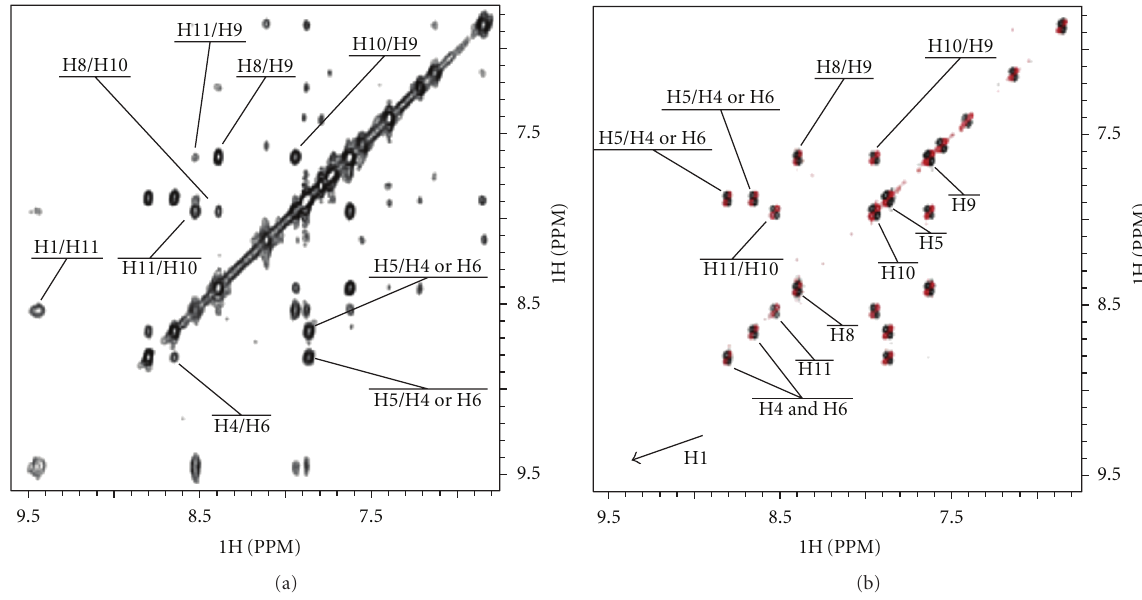
Figure 2: Expanded contour plot of a 300ms mixing time NOESY spectrum (600 MHz) of the 14-mer dG( N 2 )-3ABA duplex dissolved in 100% D 2 O phosphate bu ff er, pH 6.9 (left), depicting NOE interactions among the aromatic protons of the duplex. NOE peaks are particularly strong among the aromatic 3ABA protons facilitating their assignment. Especially relevant is the 3ABA(H1-H11) cross-peak which allows identification of the di ff erent aromatic rings. Identical region of a DQF-COSY spectrum recorded under the same conditions (right) showing J-coupling interactions that confirms the NOE-based assignments. The arrow points to the position of the H1 diagonal peak, which is missing on the DQF-COSY spectrum due to the absence of coupling interactions. Labels show the specific assignments of the aromatic protons of 3ABA, with the exception of H4 and H6 where it was not possible. The numbering scheme is shown in Figure